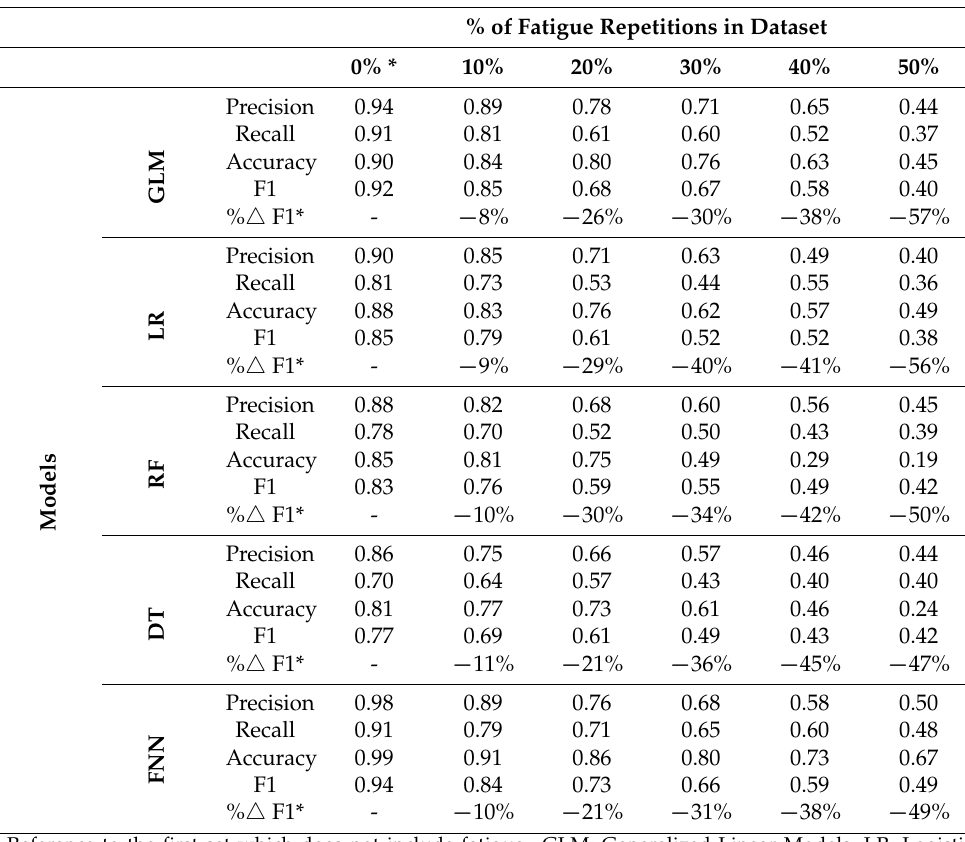
Table 7. The performance averages for subject-specific models to detect biceps repetitions throughout the incremental replacement of fatigue